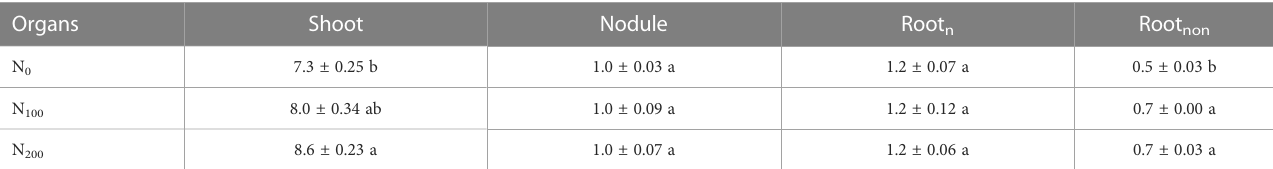
TABLE 1 Dry weights of dual-root soybean plants (g plant -1 ).